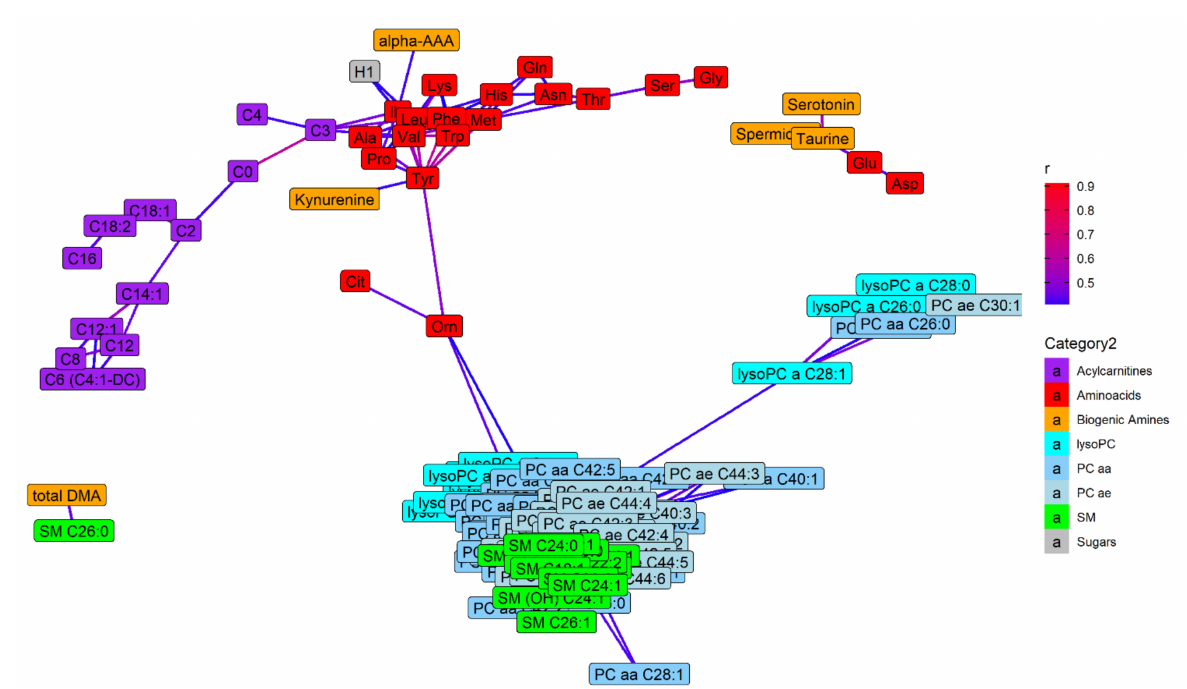
Figure 3. Network analysis performed considering metabolites as nodes and correlation coefficients (r) obtained from each pair of metabolites as edges. The Fruchterman–Reingold force-directed layout algorithm was used, and the edge weights were set on the value of r. Only statistically significant correlations with r > 0.4 were considered and metabolites with no connection were removed.